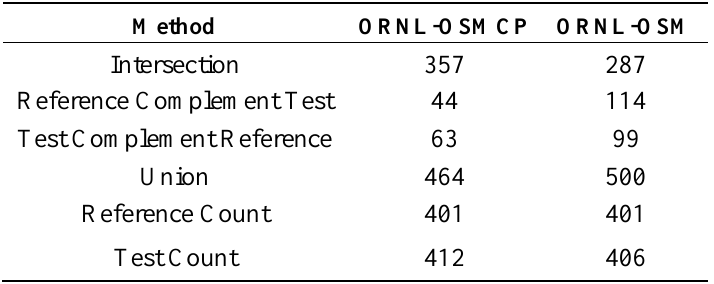
Table 4. Summary of record counts for data